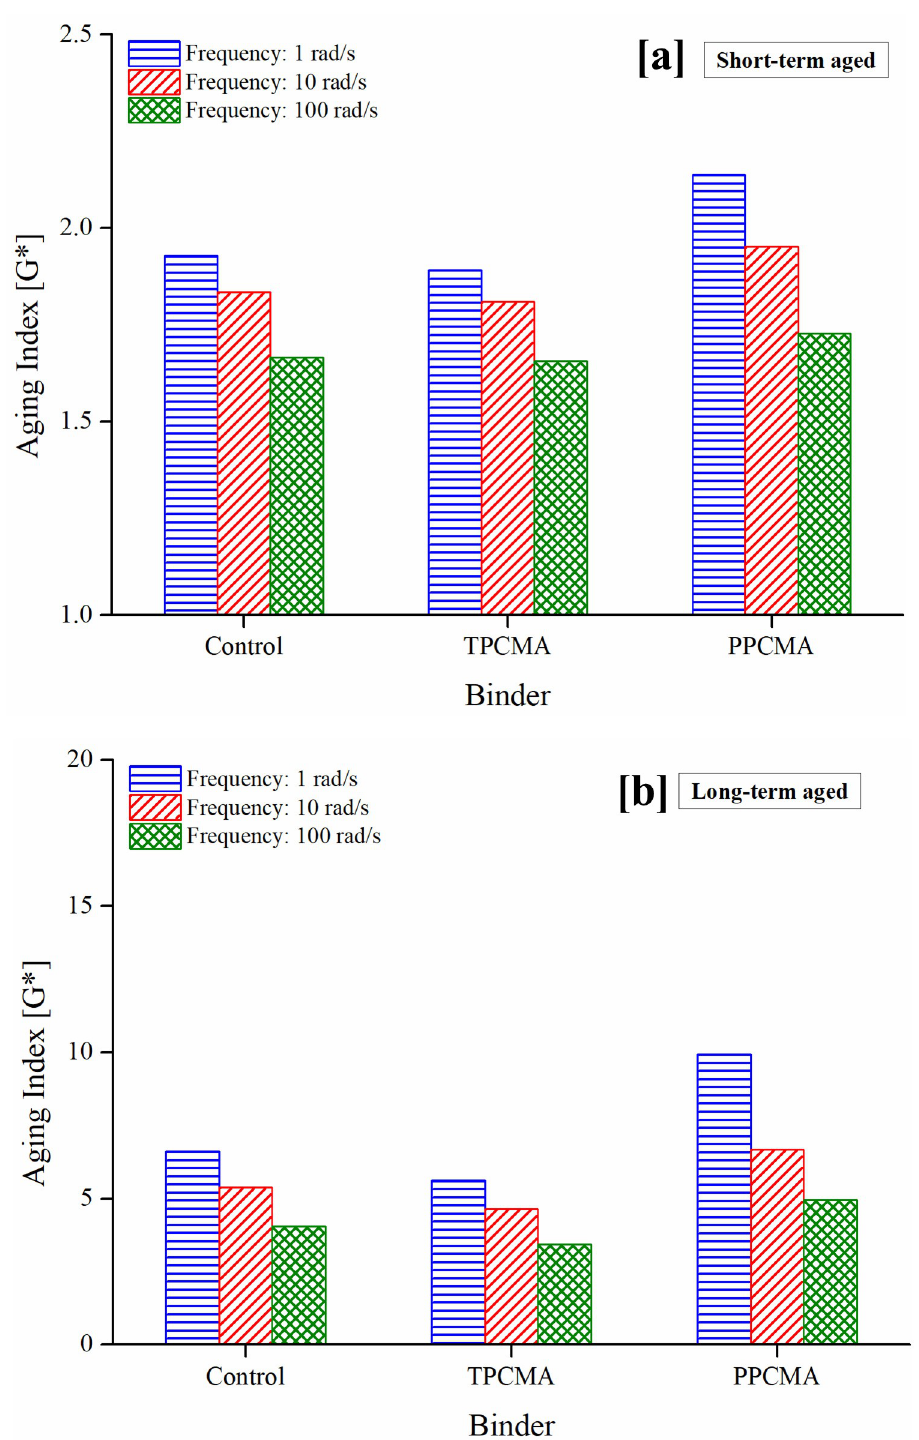
Fig 5. Aging index based on G � under (a) short-term aging, and (b) long-term aging.